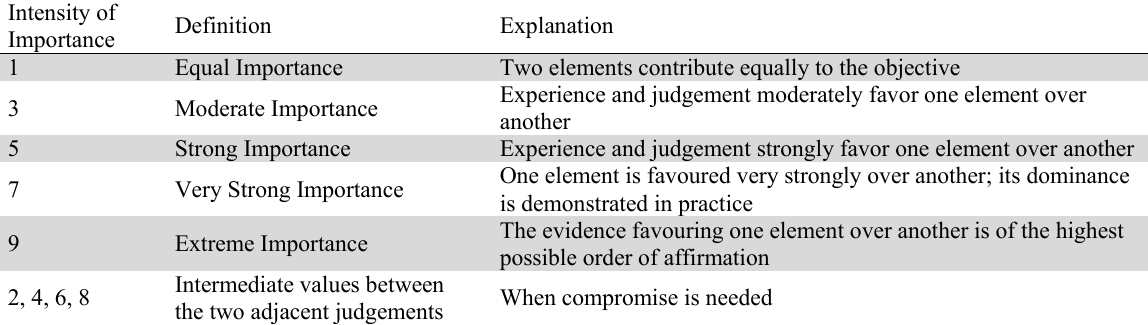
The pairwise comparison scale (Saaty, 1990)